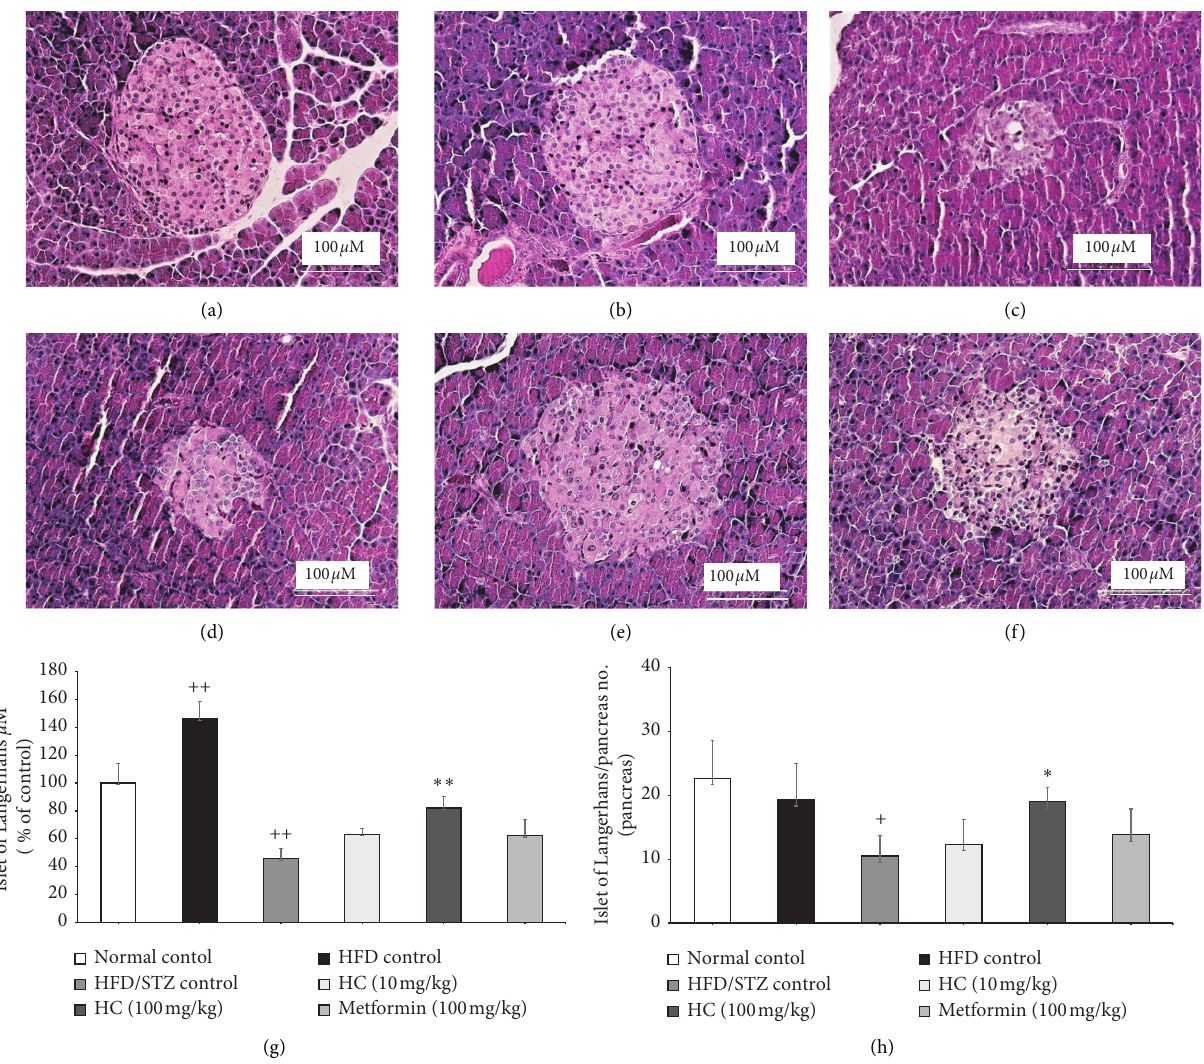
Figure 5: Histological analysis of pancreatic tissue sections stained with H&E. (a) Normal control; (b) HFD control; (c) HFD-STZ control; (d) HC 10mg/kg; (e) HC 100mg/kg; (f) metformin; (g) Islet of Langerhans area; (h) Islet of Langerhans/pancreas number. Magnitude 40x. + p < 0 . 01 and ++ p < 0 . 001 versus normal control group. ∗ p < 0 . 05 and ∗∗ p < 0 . 001 versus HFD-STZ control group. Results are presented as means ± SD ( n � 6 each